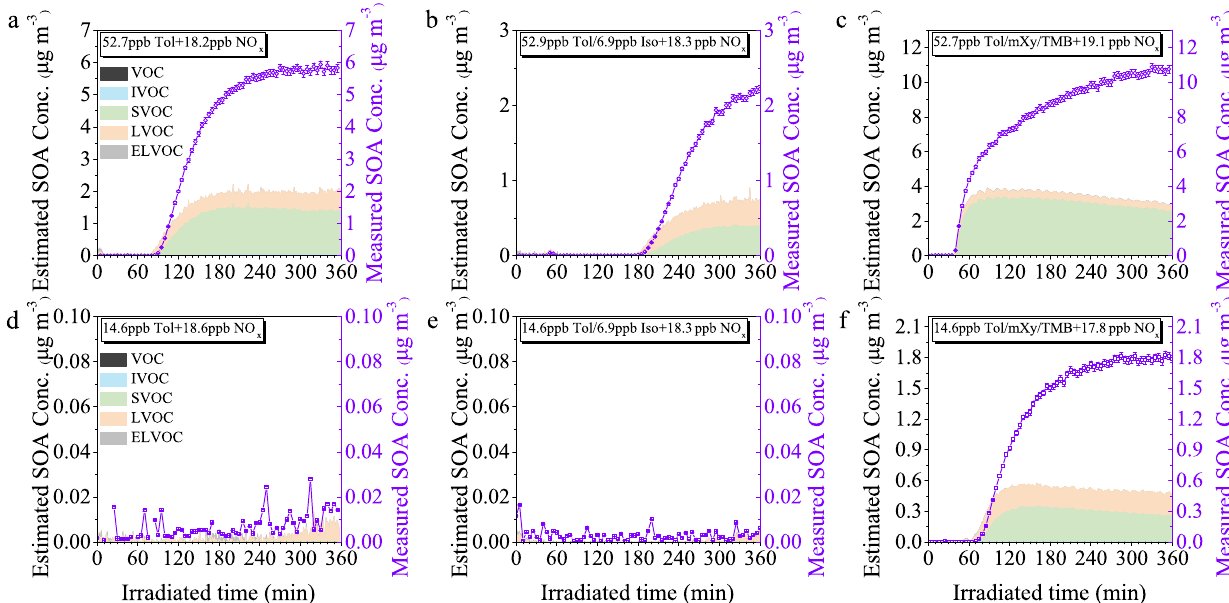
Fig. 3 Time series of estimated SOA concentrations. Estimated SOA concentrations derived from intermediate products (left y -axis) and measured SOA concentrations (right y -axis) under different mixed VOC scenarios (i.e., toluene, mixed toluene, and isoprene, as well as mixed toluene, m-xylene, and 1,3,5-trimethylbenzene) in the presence of NO x (~20 ppb) at a – c higher and d – f lower VOC concentration levels. The detailed experimental conditions can be found in Table by the cross-reactions of RO 2 with odd and even oxygen numbers from different VOC precursors 35,50 . For example, C 9 H 14 O 5 shown in Fig. 2 can be attributed to the cross-reaction of CH 3 O 2 radical and C 8 H 11 O 5 radical, which are formed in the photo-oxidation of toluene and m-xylene, respectively. In addition, the cross-reaction